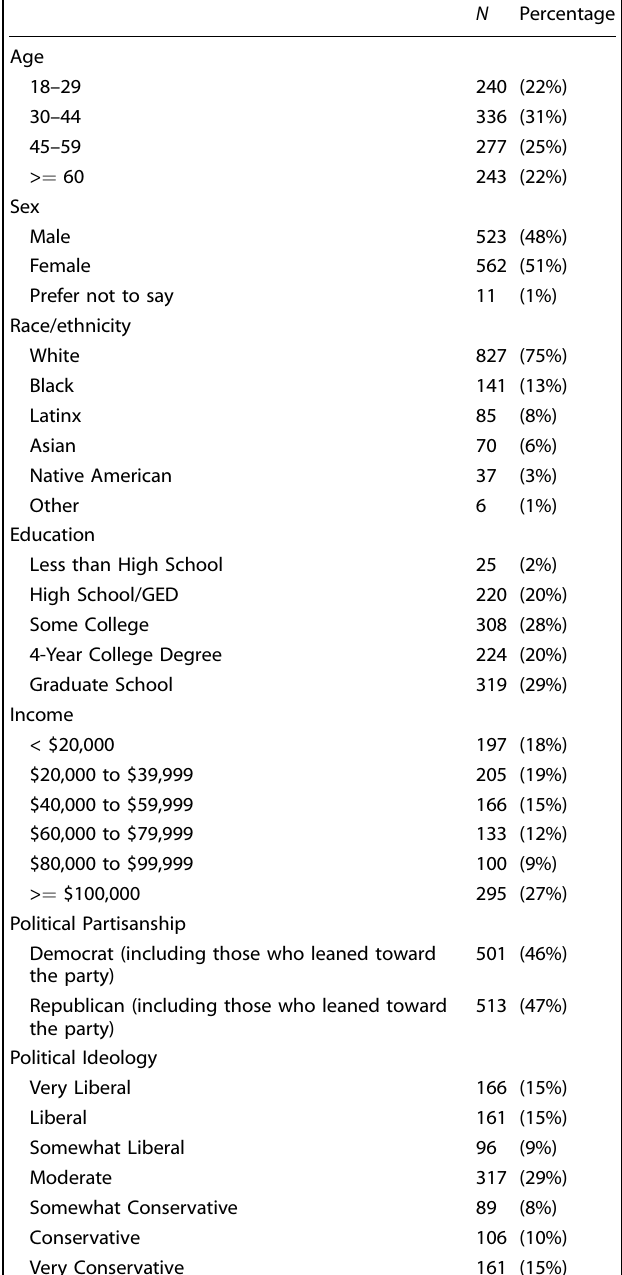
Table 1. Sample demographic. Table 2. Attributes and attribute levels for hypothetical COVID-19